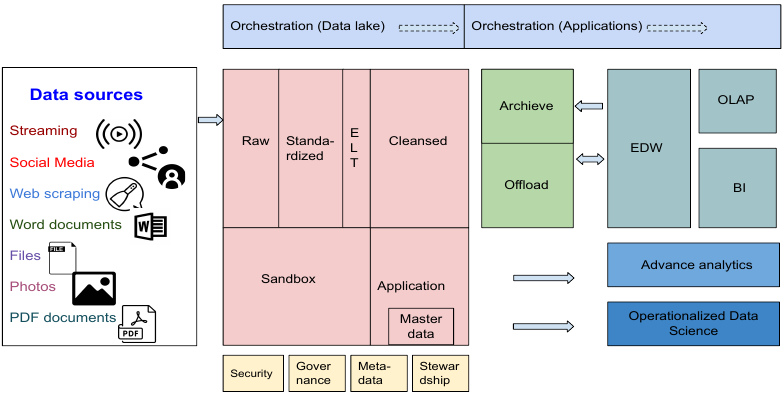
Figure 3. Data lake building